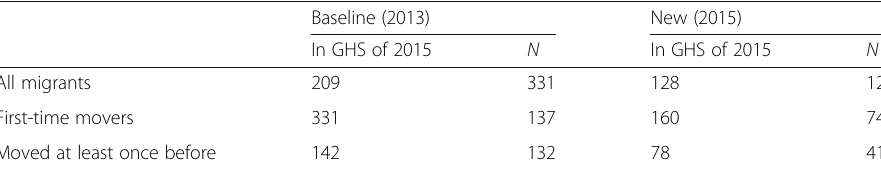
Table 3 Migration costs